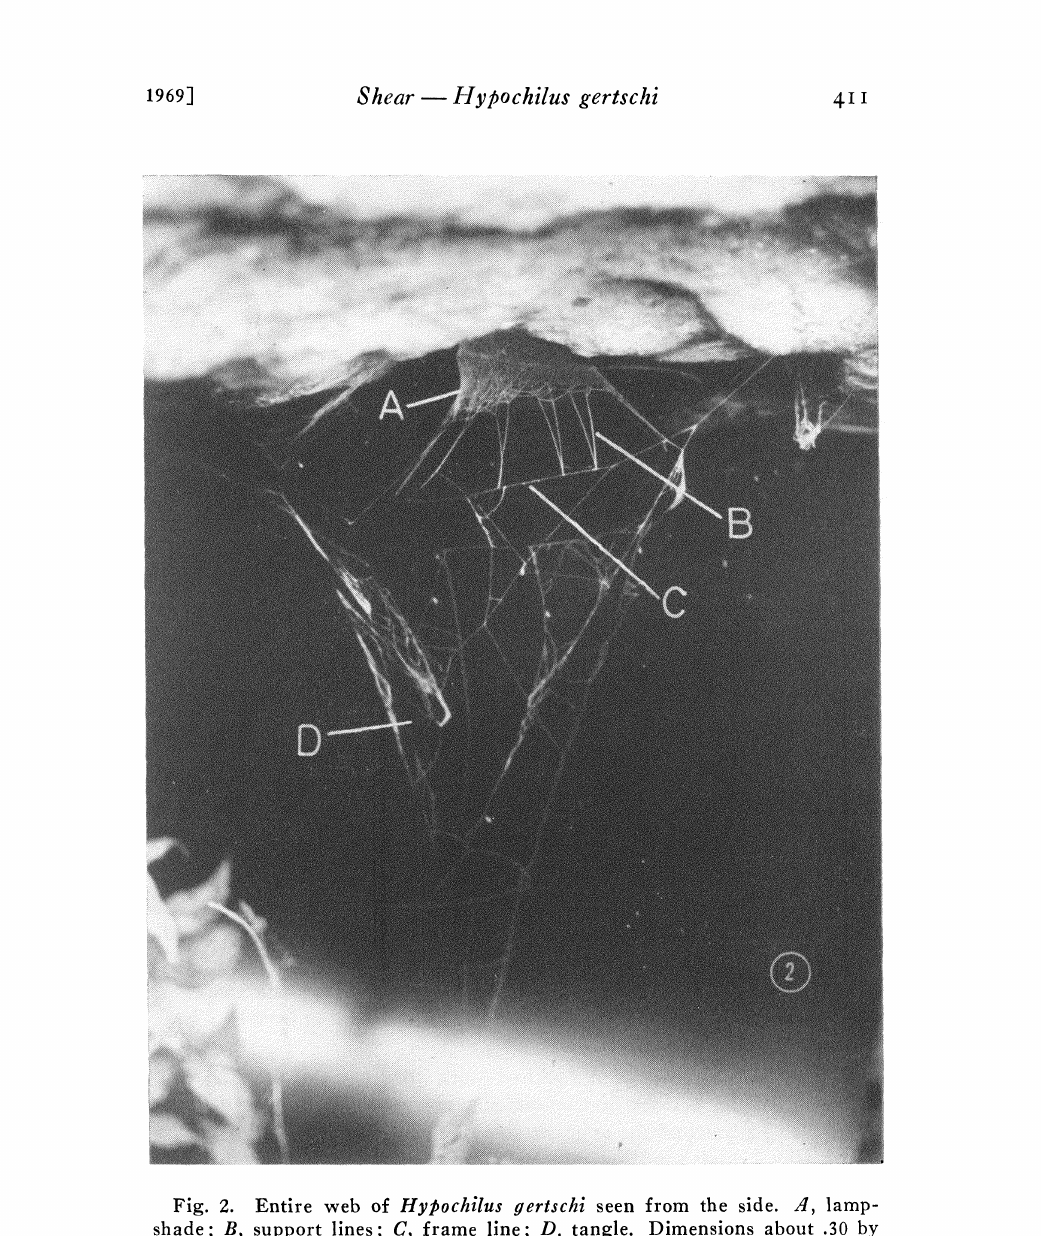
Fig. 2. Entire web of Hykochilus gertschi seen from the side. /, lamp- shade; B, support lines; C, frame line; D tangle. Dimensions about .30 by